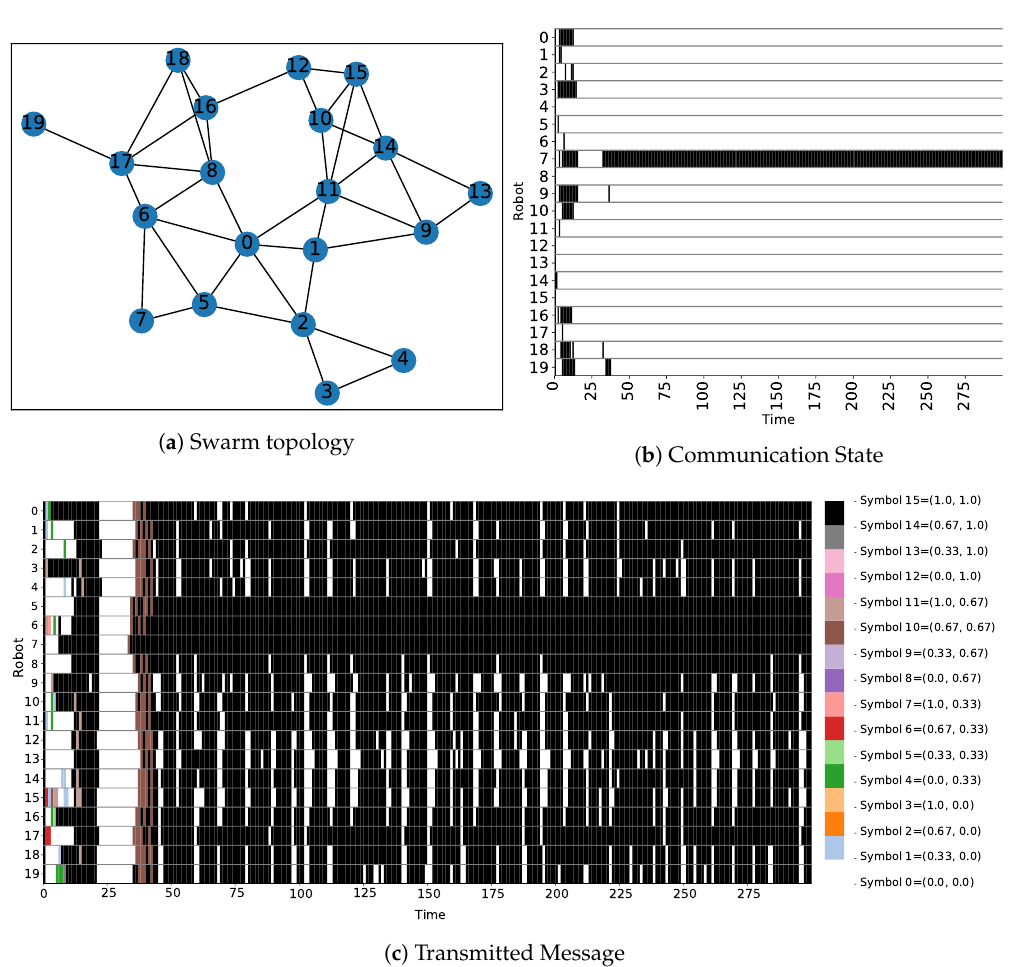
Figure 9. ( a ) Spatial graph of the swarm topology, preserving positions and distances. ( b ) Communication state of each robot at each time step. Horizontal black bars correspond to state send and horizontal blank bars denote relay state. ( c ) Message transmitted by the robots at each time instant. The color of the bar at each time step corresponds to a symbol specified in the